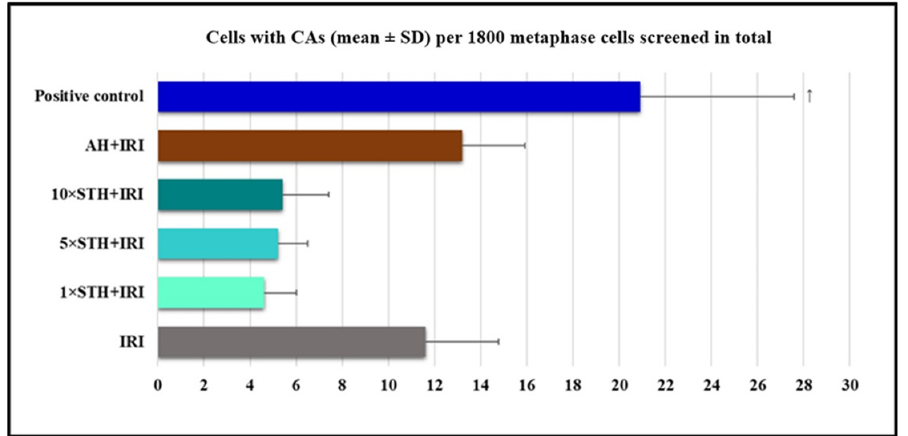
Figure 2. Frequency of cells according to CA assay after treatment with different combinations of cytotoxic drug irinotecan (IRI) with strawberry tree honey (STH) and artificial honey (AH). Single-IRI-treated cells and positive control (bleomycin—15 mg/L) cells were studied in parallel. Significantly increased ( p < 0.05) value is ↑ —vs. all other experimental groups.